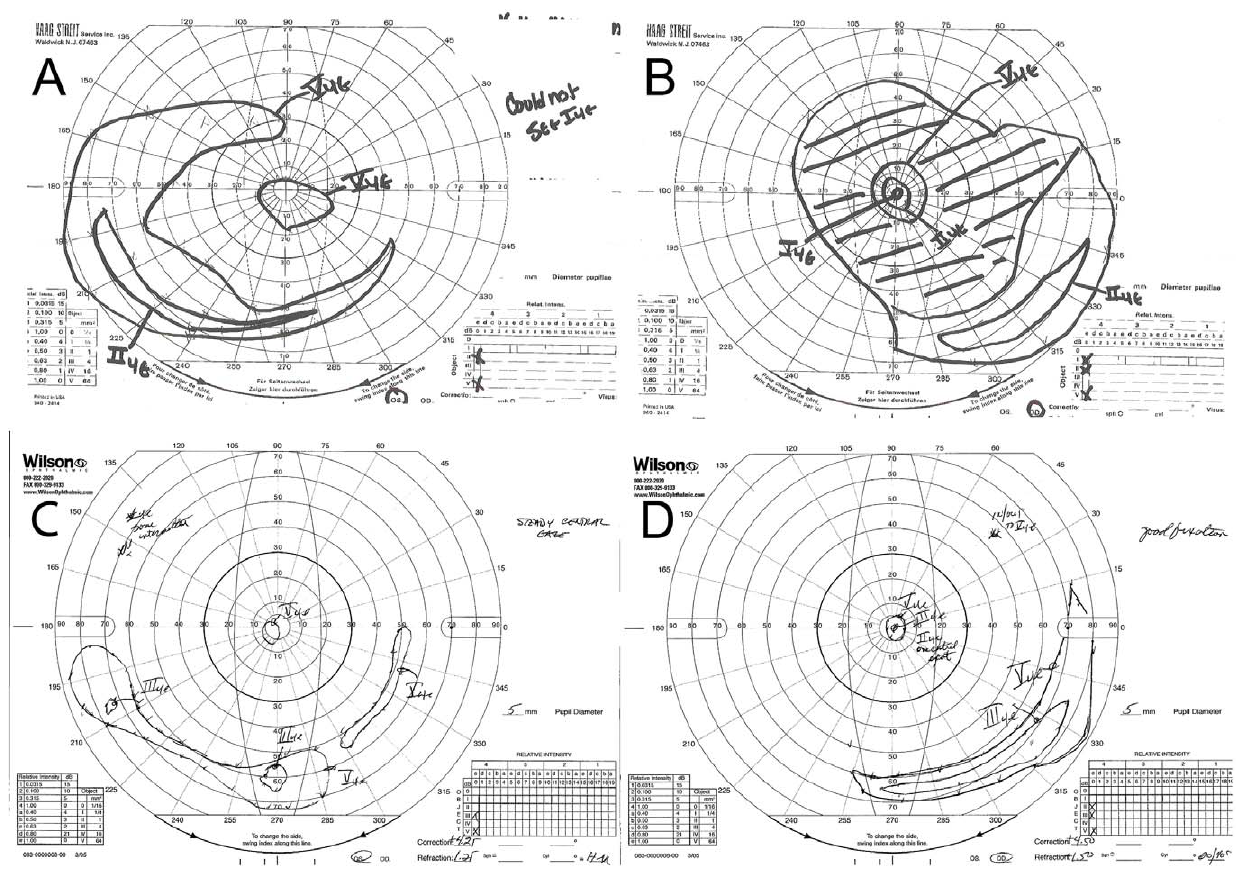
Figure 3. Goldman Visual Field (GVF) of the patient IV-4 at age 38 and at age 55. GVF demonstrated progressive loss from retinal disease. At age 38, both eyes showed a central ‘‘tunnel’’ vision of 15 degrees and large peripheral temporal islands OU (panel A and B), but by age 55, these had constricted to less than 5 degrees, with a small temporal islands for both eyes (panel C and D). doi:10.1371/journal.pone.0050205.g003 ERG scotopic rod-driven responses were not detectable at either visit (data not shown). Cone photopic single flash responses were approximately 80% reduced at age 38 years, and these residual cone responses were further reduced to the level of noise 17 years later (Figure 4A). 30 Hz flicker ERG testing demonstrat- ed a similar decline in this cone elicited response (Figure 4B).